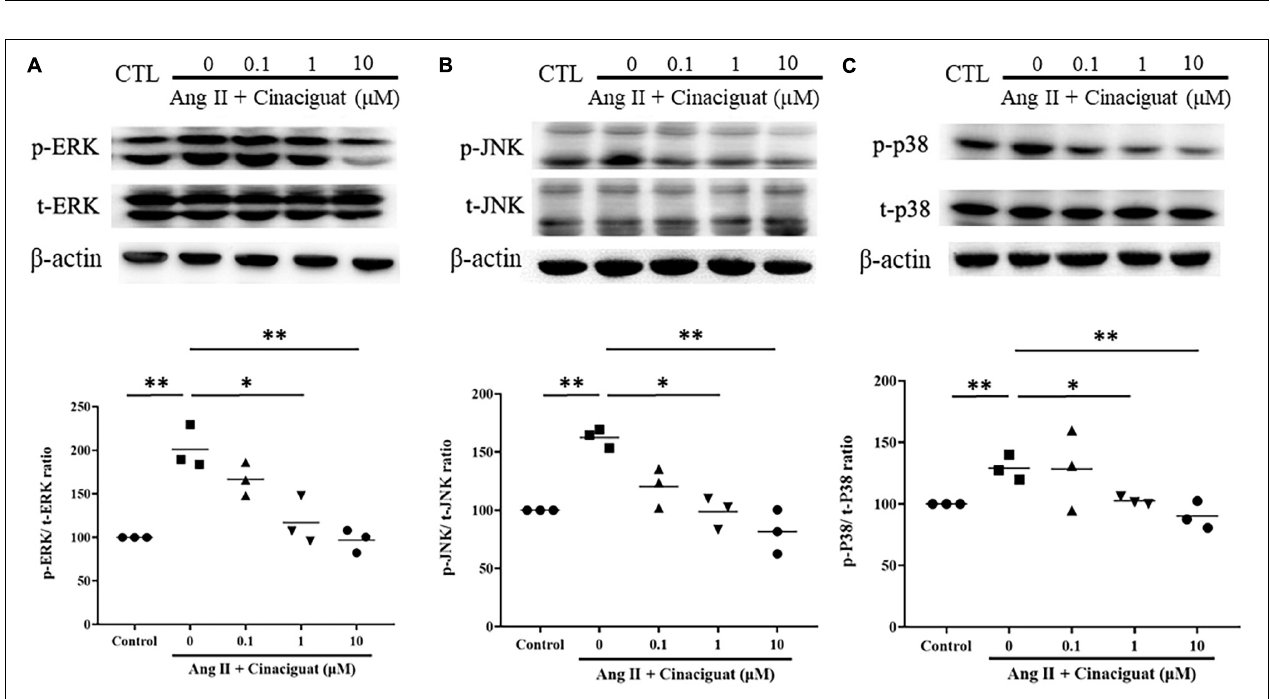
FIGURE 6 | Cinaciguat-inhibited Ang II-induced mitochondrial reactive oxygen species (ROS) production. The fluorescent photomicrograph showed the mitochondrial ROS (red color) in ductus arteriosus smooth muscle cells (DASMCs). Ang II induced ROS production, but when co-treated with cinaciguat, the ROS production declined. The bar graph showed the fluorescence intensity of ROS in different doses. Values represent the mean ± SEM; N = 6. One-way ANOVA P < 0.0001. ## P < 0.01 vs. control; ** P < 0.01 vs. Ang II alone (magnification 200 × ).